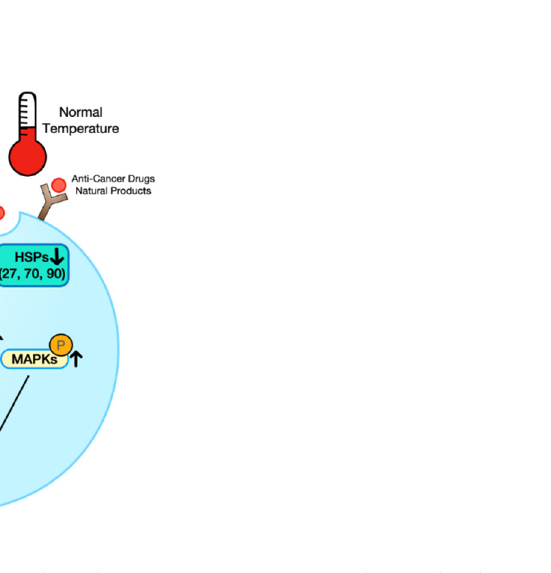
Figure 1. Synergic effect of HT + natural product or anticancer agent and its molecular